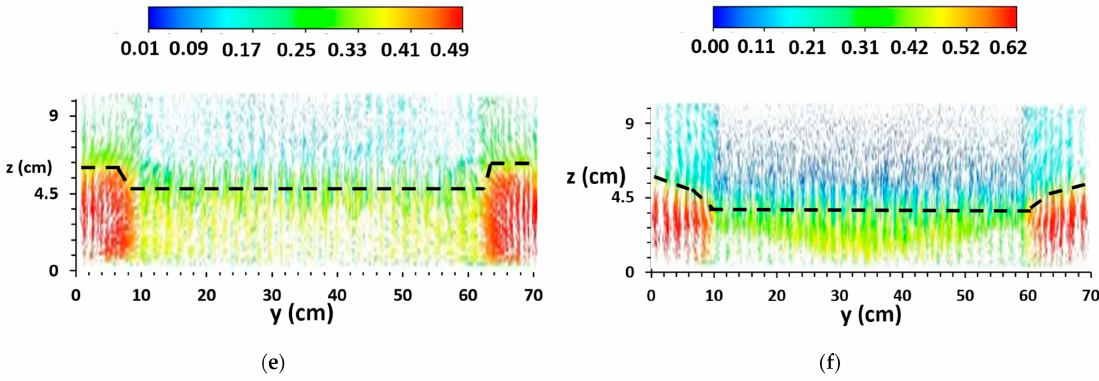
Figure 12. Streamwise velocity vectors (m/s) along the specified cross sections CS1 and CS2 ( a , b ) Case 1; ( c , d ) Case 3; ( e , f ) Case 5. The black dashed lined shows the FSL (Free Surface Level).